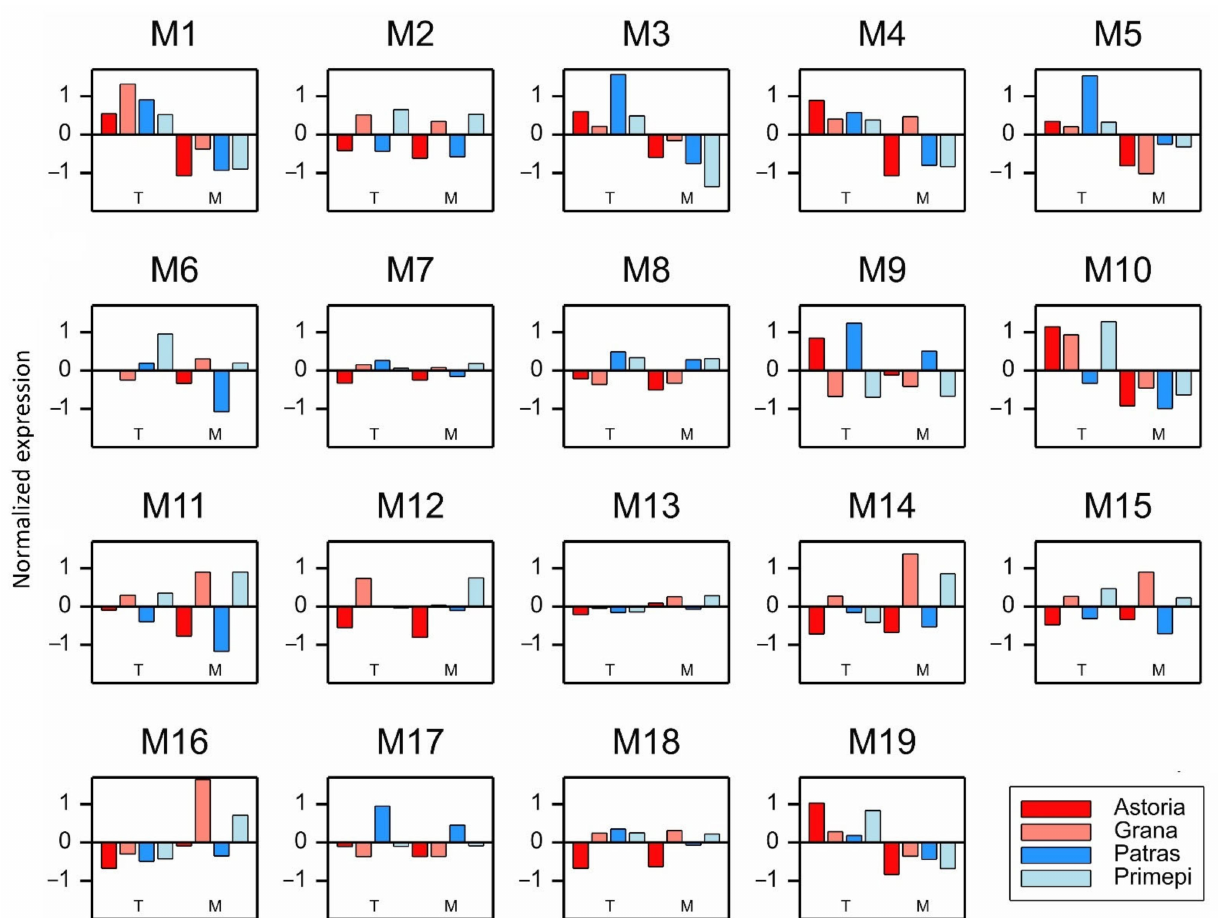
(Table S3). An analysis of individual PAGs in this group indicated that the expression levels of most of the PAGs were consistent with the normalized profile. The six exceptions were PAG32, PAG34, PAG38, PAG44, PAG48, and PAG51, which were more highly expressed in Astoria than in the other three cultivars. Three other PAGs were expressed at higher levels in both restorers than in both non-restorers, but only in one developmental stage (PAG40 and PAG52 in the M stage and PAG45 in the T stage). However, if compared only with Astoria, the expression levels of most PAGs were higher in both fertility-restoring cultivars in the T and M stages, which is similar to the normalized profile. In cluster M18, three PAGs (PAG41, PAG44, and PAG50) belonged to the ADD family, whereas the remaining 18 PAGs were members of the PPR family. The expression patterns of individual PAGs from clusters M9, M17, and M18 are presented in Figure S1.